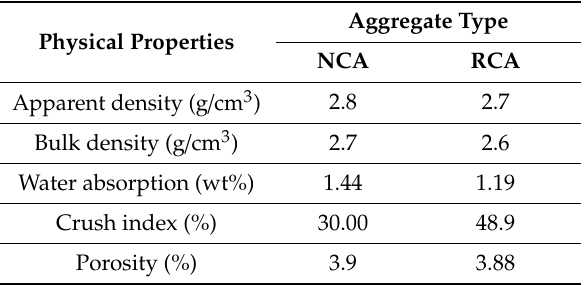
Table 1. Physical and chemical properties of RCA and NCA.